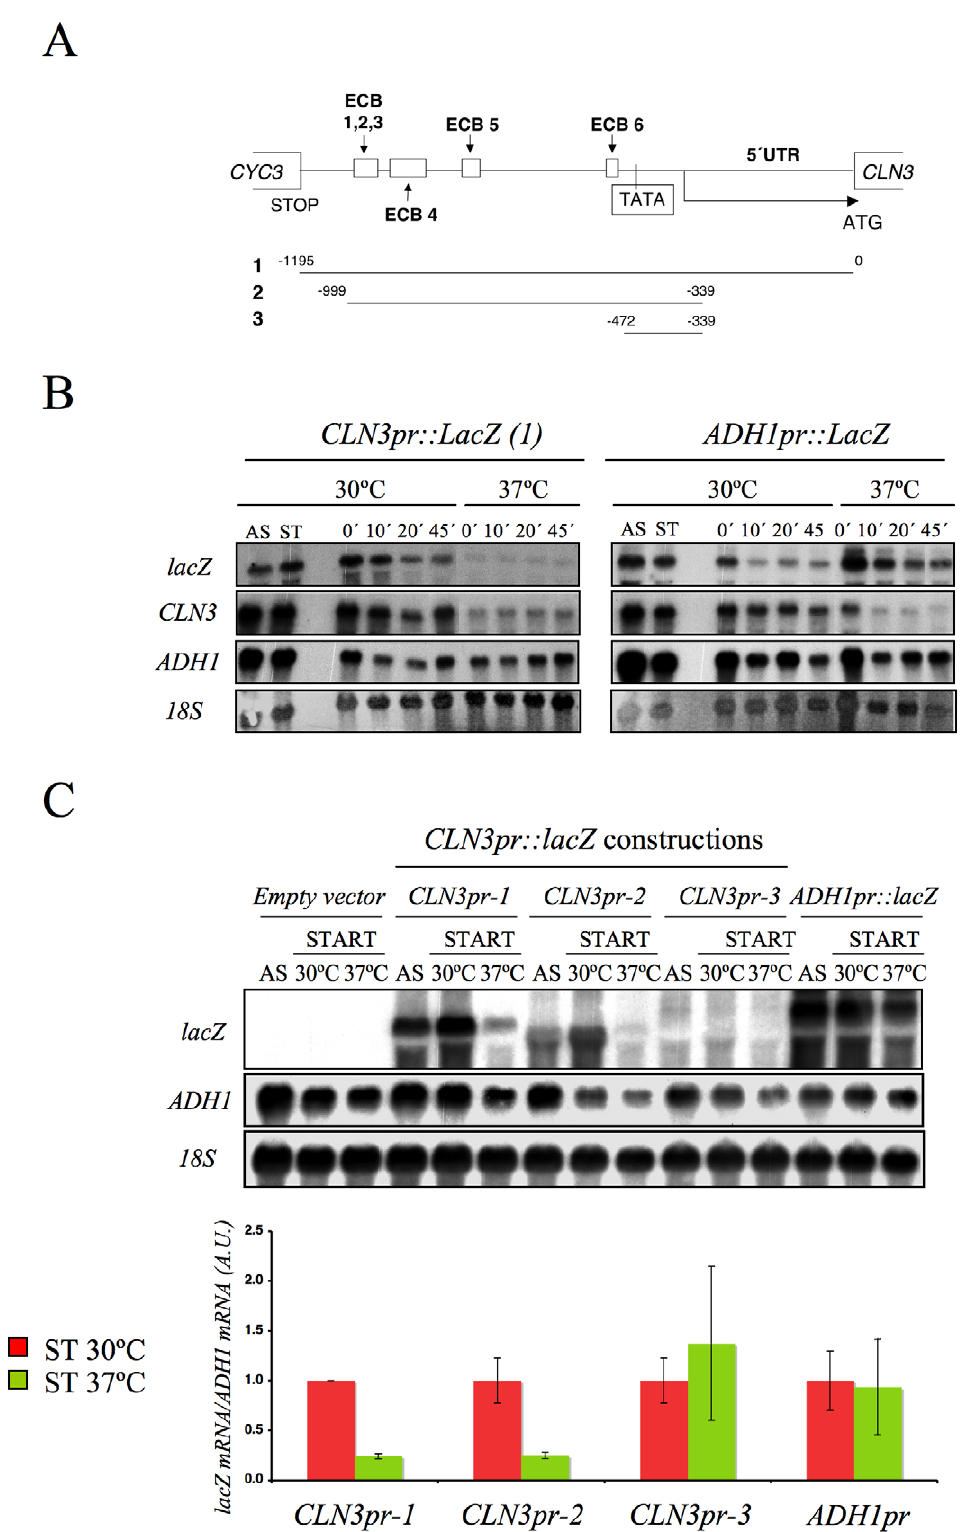
Figure 2. The CLN3 promoter mediated the down-regulation of its mRNA levels after Spt16 inactivation. (A) Diagram of the plasmid- borne lacZ fusions, encoding E. coli ß-galactosidase, that were generated by introducing different fragments of the CLN3 promoter region. Constructions were numbered 1 to 3. The positions of the early cell cycle boxes (ECB) and the TATA box are indicated. An ADH1 promoter- lacZ fusion was used as a constitutively expressed control. (B) The mRNA levels of CLN3 pr:: lacZ and ADH1 pr:: lacZ fusion. The spt16-197 (FY348) strain, transformed with the plasmids bearing lacZ fusion number 1 ( CLN3 pr:: lacZ ) or ADH1 pr:: lacZ , was grown until the mid-log phase (AS), and was then synchronized at START (ST) by alpha-factor treatment for 2h at 30 u C, followed by one additional hour of incubation at 30 u C or 37 u C in the presence of the mating